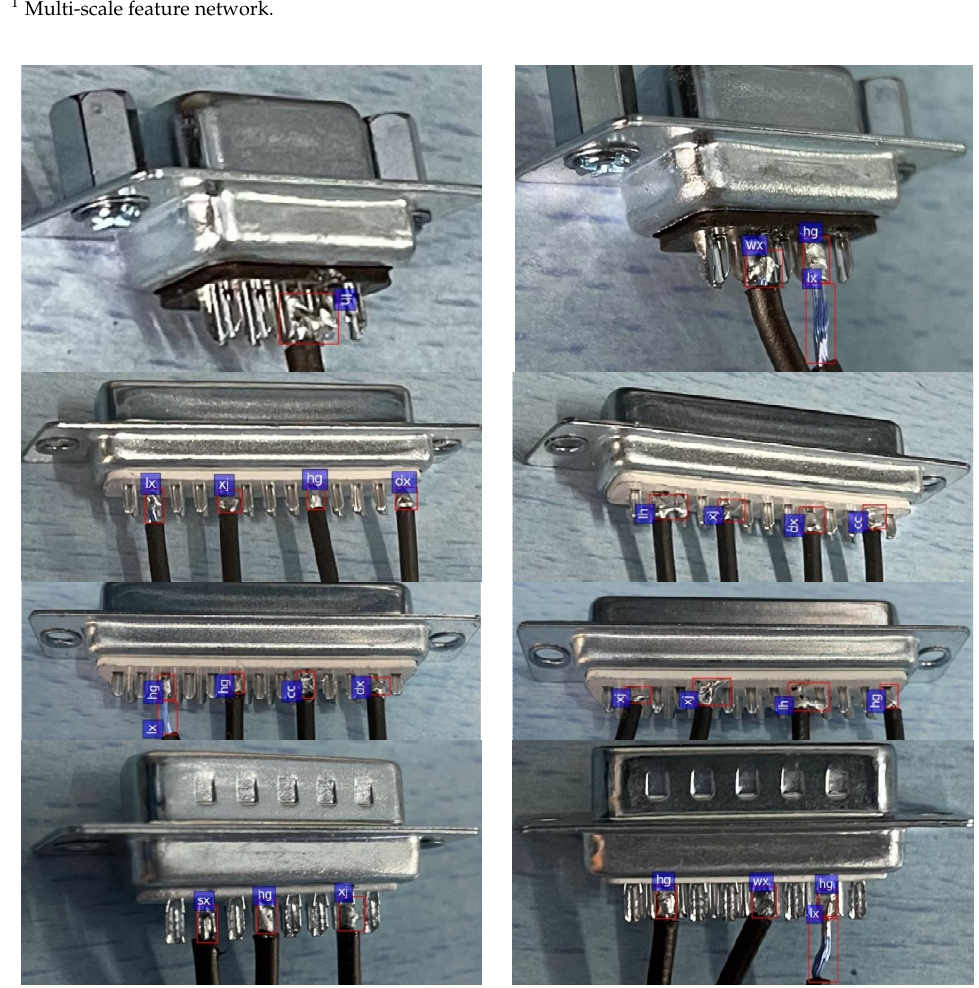
Figure 8. Classification and positioning results of solder joint instances in the connectors.